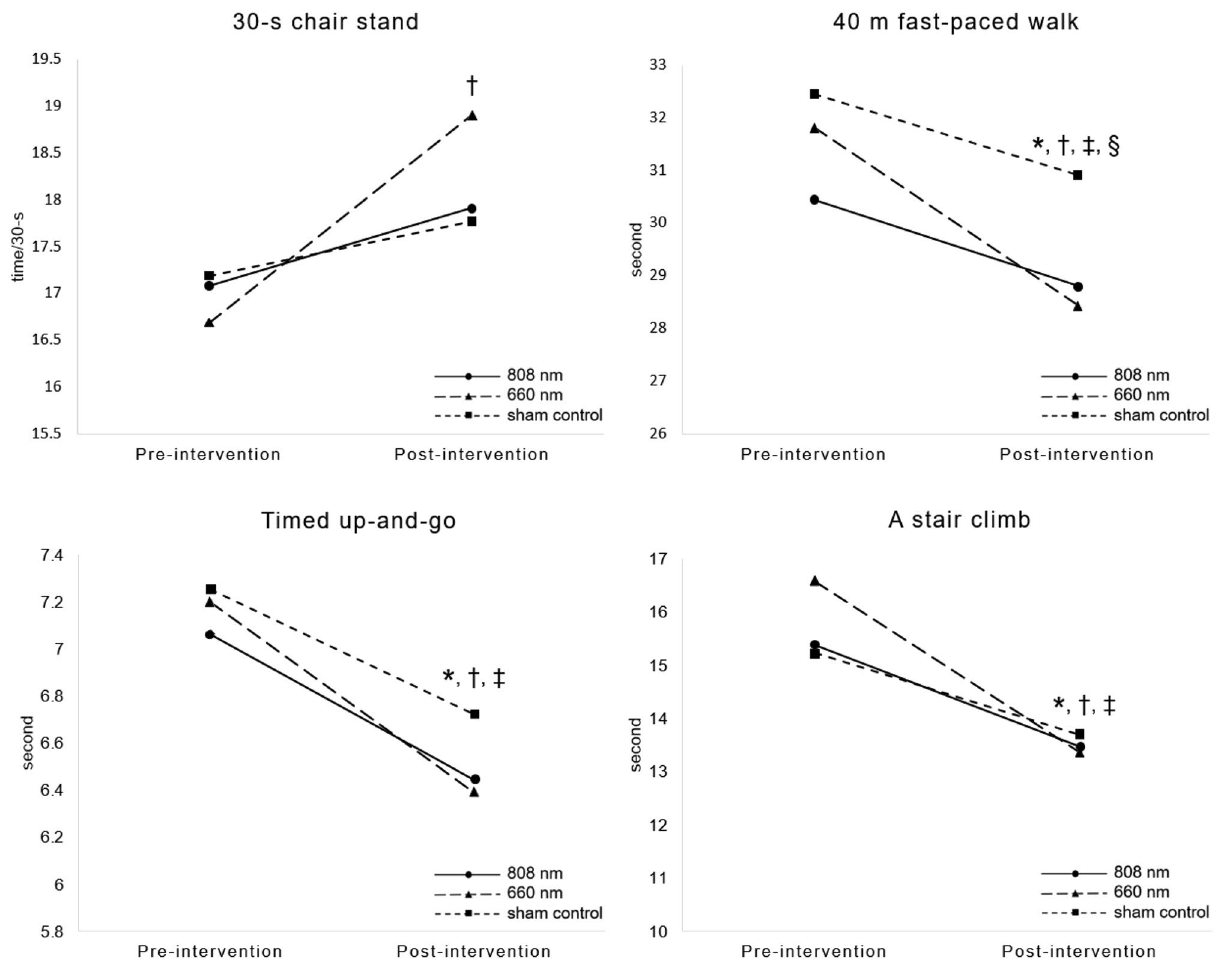
Figure 4. Comparison of the pre-and post-intervention functional performance-based test for the 808 nm, 660 nm, and the sham control groups. * indicates a statistically significant difference between pre-and post- intervention for the 808 nm group; † indicates a statistically significant difference between the pre-and post- intervention for the 660 nm group; ‡ indicates a statistically significant difference between the pre-and post- intervention of the sham control, and § indicates a statistically significant difference between the 660 nm and the sham control